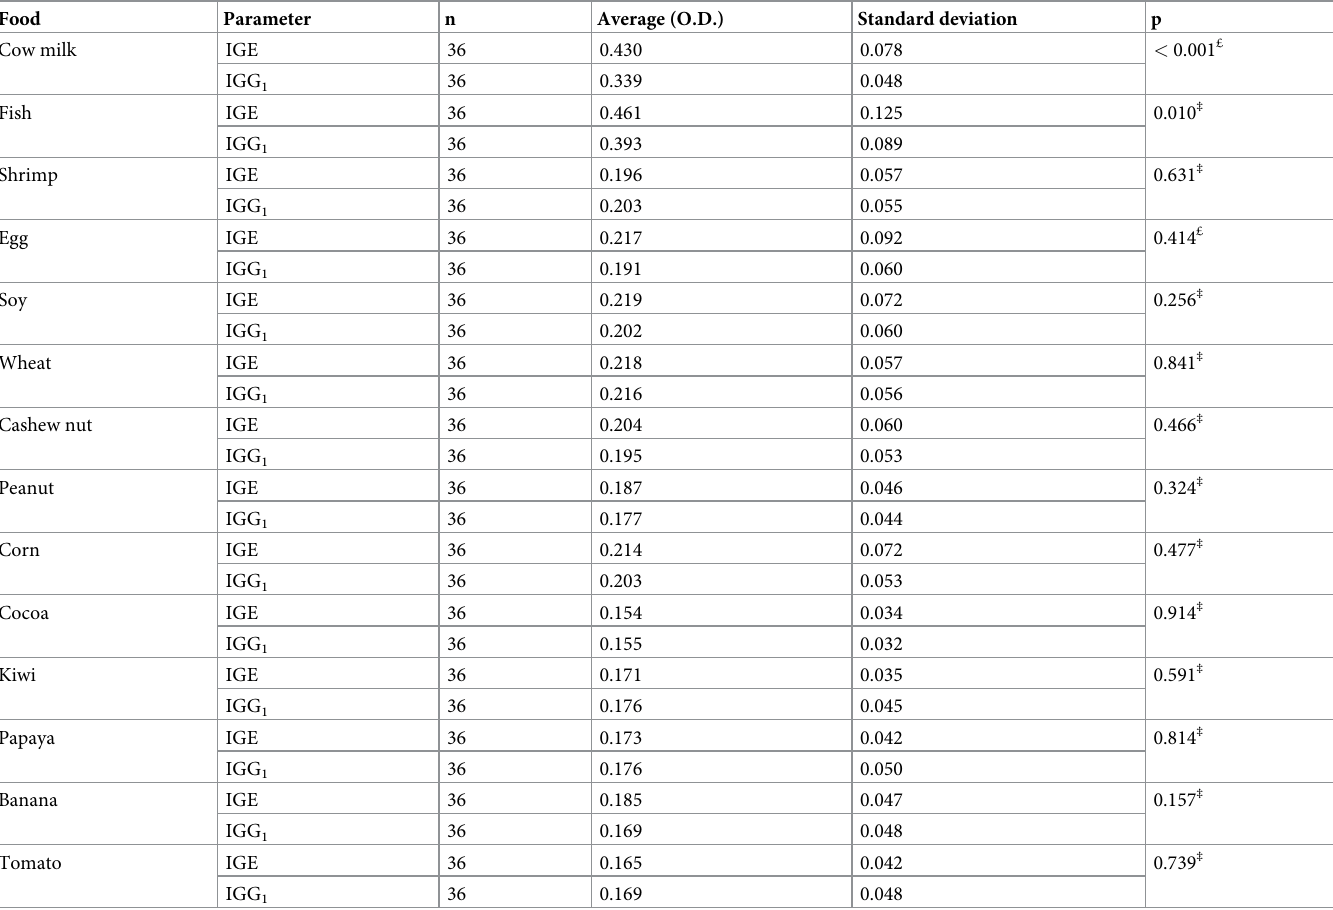
Table 3. Comparing the average concentration of IgE with the concentration of IgG1 in serum in each food by ELISA test. Food Parameter n Average (O.D.)